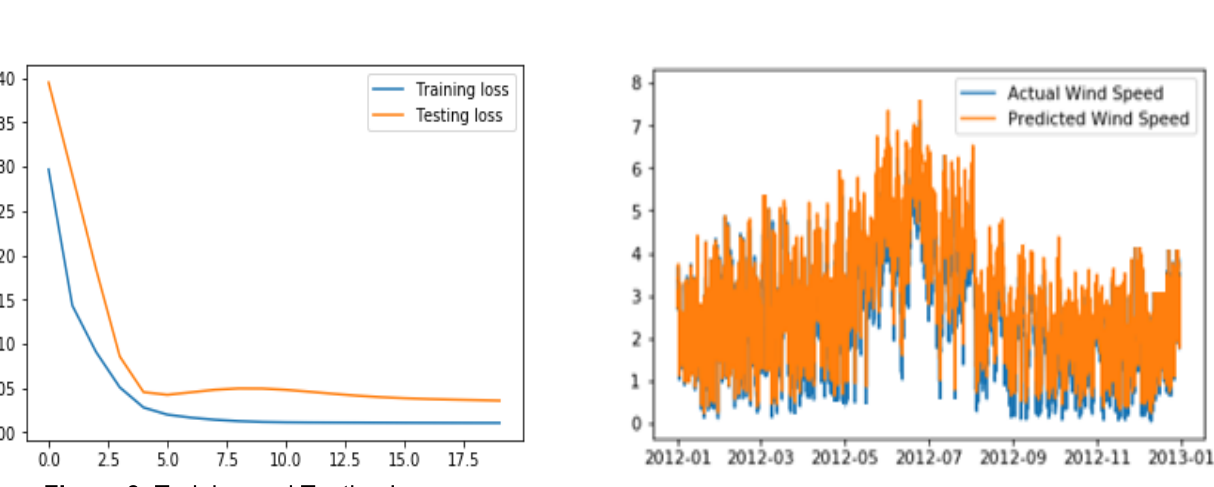
Figure 9. Training and Testing Loss